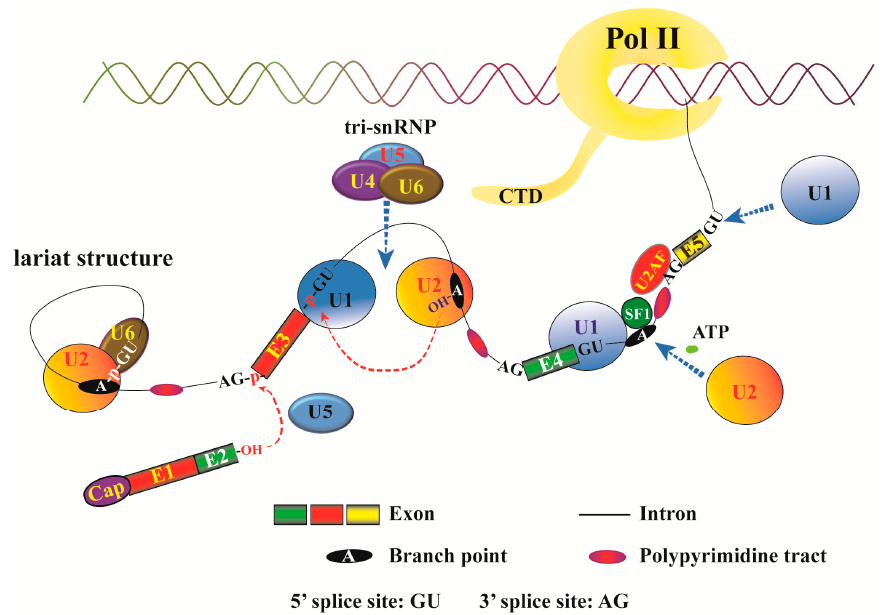
Figure 1. Schematic diagram of spliceosome assembly during pre-mRNA splicing. RNA transcription and pre-mRNA splicing can concurrently occur [13]. The representation depicts pre-mRNA splicing events among nascent exons 2, 3, 4, and 5 with already processed splicing between exons 1 and 2. A canonical spliceosome contains five small snRNPs, U1, U2, U4, U5, and U6. The 5 ′ and 3 ′ splice sites, branch points, and polypyrimidine tracts of the three introns are indicated. U1 snRNP, and splicing factors SF1 (splicing factor 1) and U2AF (U2 small nuclear RNA auxiliary factor) bind to the 5 ′ splice sites, branch points, and polypyrimidine tracts, respectively. Then, U2 snRNP replaces SF1 at the branch points. With the recruitment of the tri-snRNP consisting of U4, U5, and U6, the spliceosome assembly is completed [4]. “CTD” denotes the C-terminal domain of RNA Polymerase II (Pol II), which can be attached by a spliceosome [14]. Dotted blue arrows indicate protein binding or recruitment, while dotted red arrow lines show nucleophilic attacks.